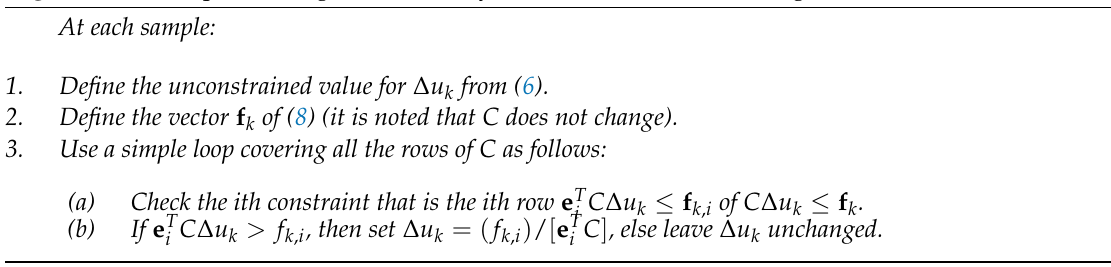
Algorithm 1. Simple PFC algorithm with systematic constraint